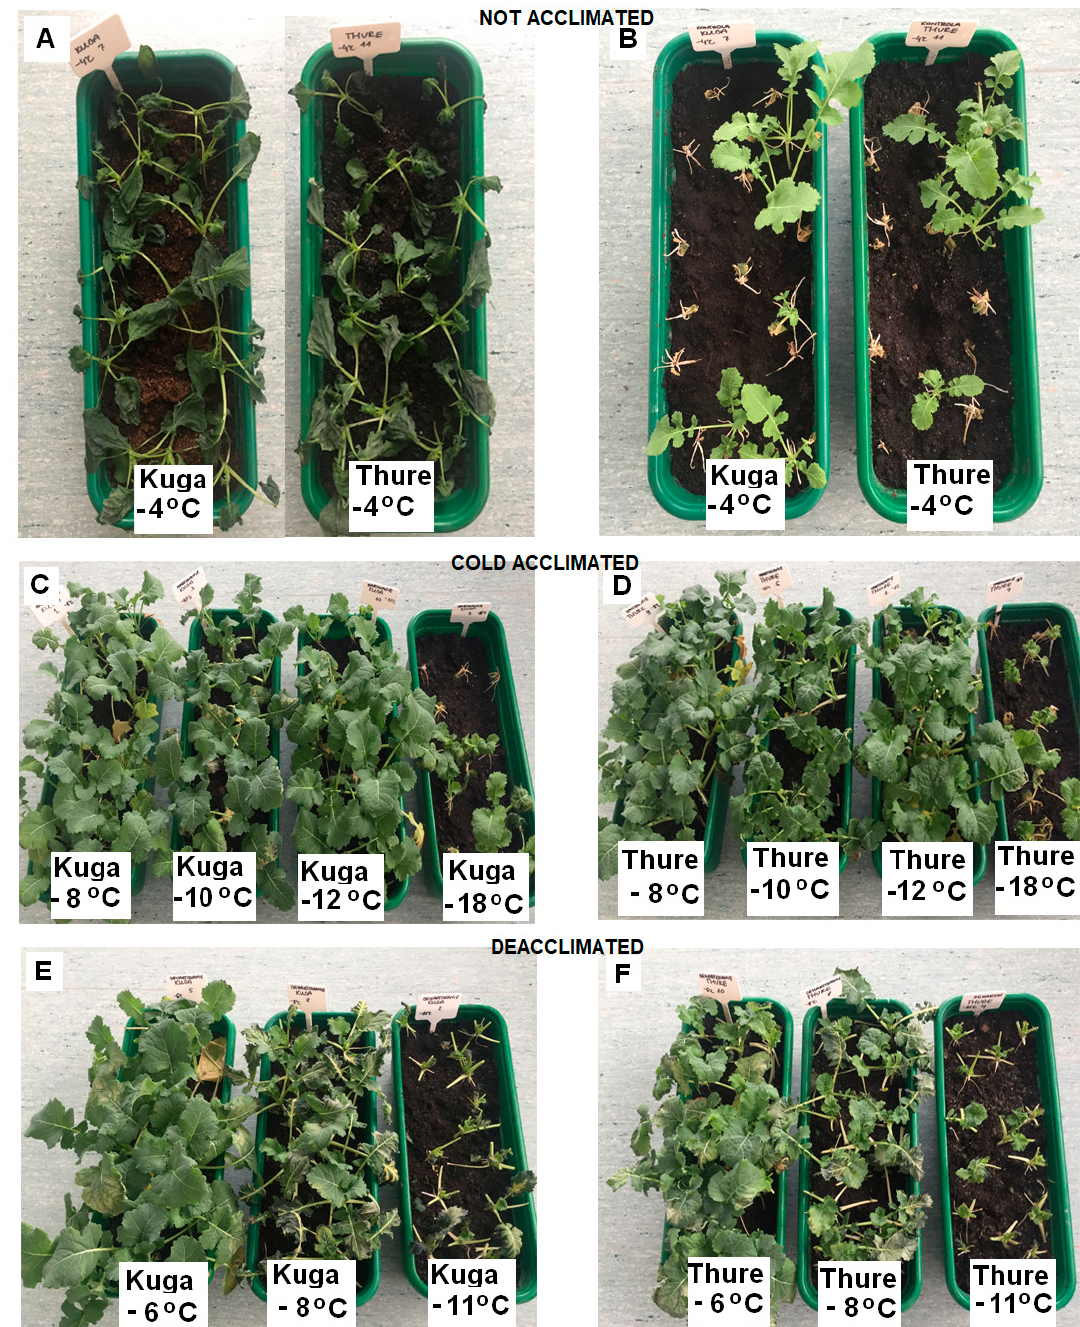
Figure 2. The Kuga and Thure oilseed rape cultivars after frost treatment. ( A ) Not acclimated oilseed rape Kuga and Thure cultivars immediately after exposure to frost at − 4 ◦ C. ( B ) Not acclimated oilseed rape the Kuga and Thure cultivars that had been exposed to frost at − 4 ◦ C and then left to regrow (two weeks at 12 ◦ C). ( C ) The cold-acclimated oilseed rape Kuga cultivar that had been exposed to frost at − 8 ◦ C, − 10 ◦ C, − 12 ◦ C, and − 18 ◦ C and then left to regrow (two weeks at 12 ◦ C). ( D ) The cold-acclimated oilseed rape Thure cultivar that had been exposed to frost at − 8 ◦ C, − 10 ◦ C, − 12 ◦ C and − 18 ◦ C and then left to regrow (two weeks at 12 ◦ C). ( E ) The deacclimated oilseed rape Kuga cultivar that had been exposed to frost at − 6 ◦ C, − 8 ◦ C, and − 11 ◦ C and then left to regrow (two weeks at 12 ◦ C). ( F ) The deacclimated oilseed rape Thure cultivar that had been exposed to frost at − 6 ◦ C, − 8 ◦ C, and − 11 ◦ C and then left to regrow (two weeks at 12 ◦ C).